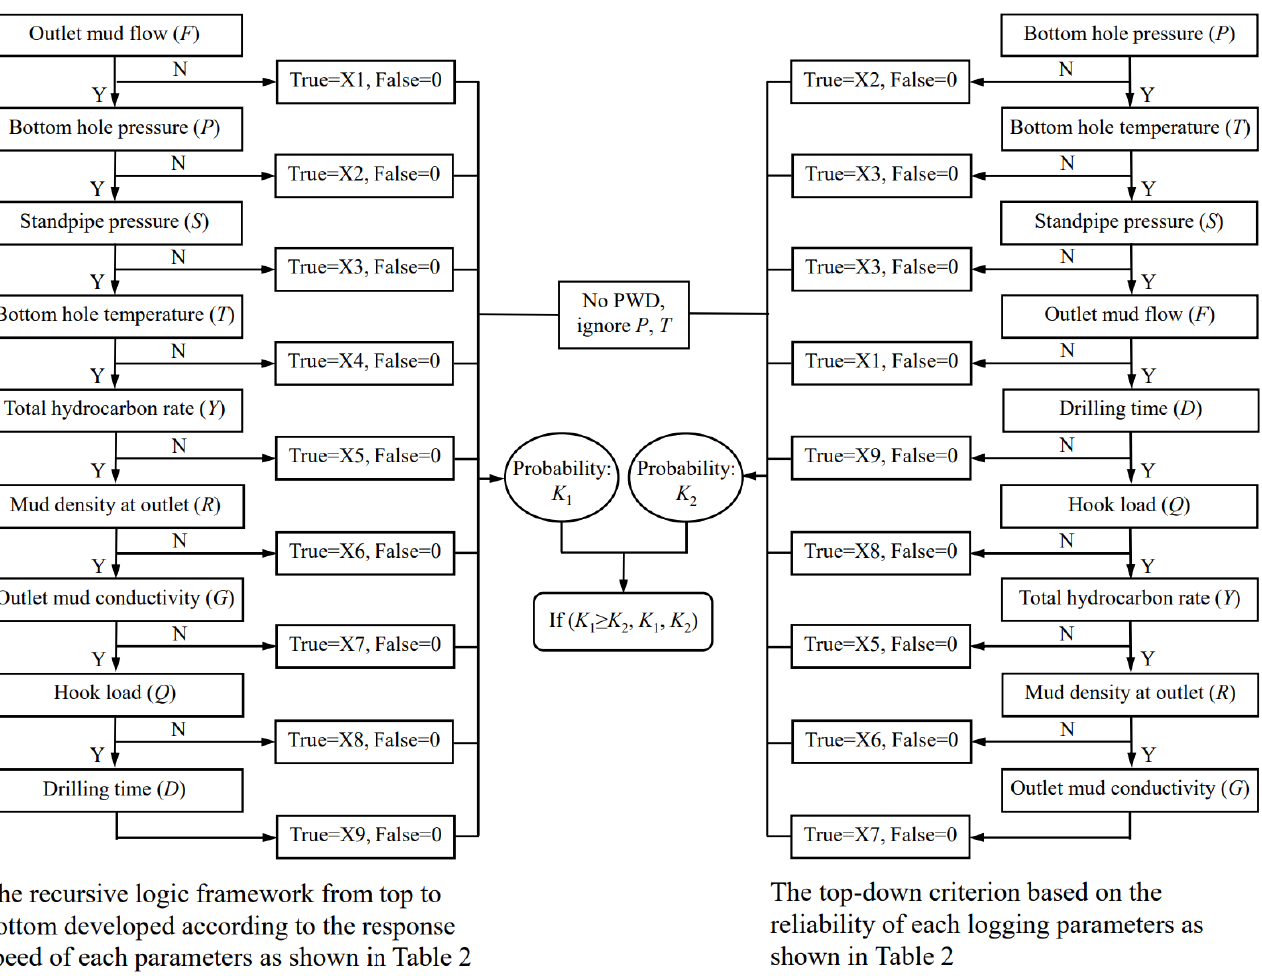
Figure 4. Flow chart of early overflow identification.